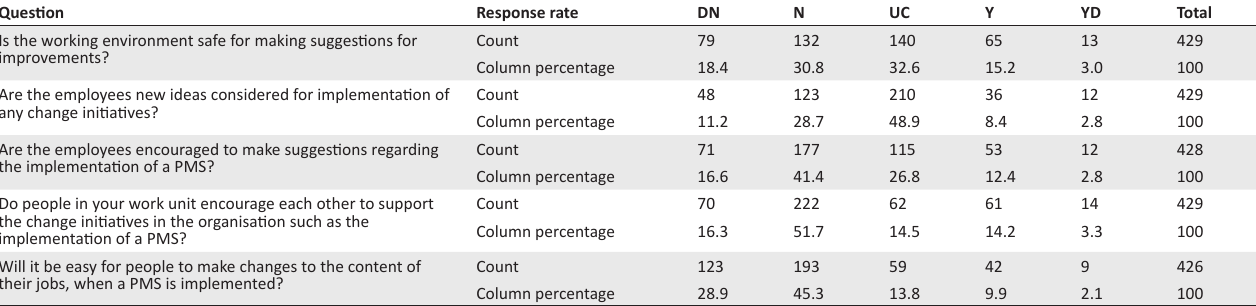
TABLE 6: Work environment in the